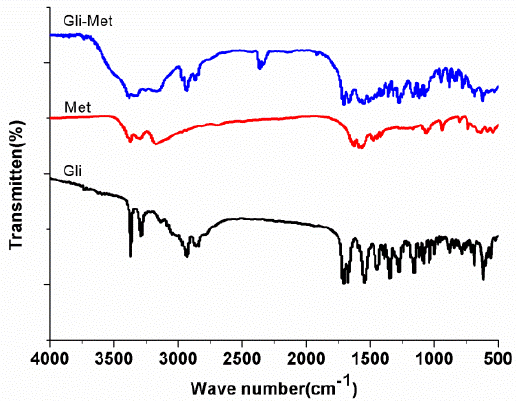
Figure 7. Infrared spectra of Gli ‐ Met, Met and Gli.